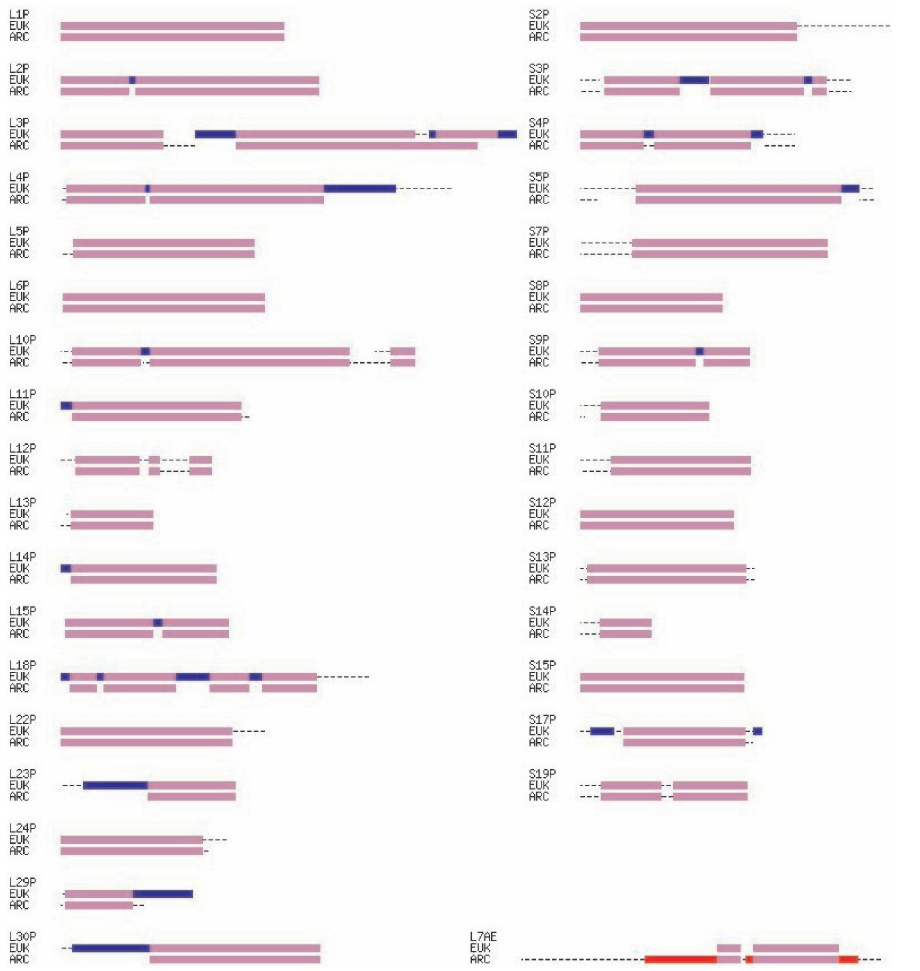
Figure 2. A schematic repre- sentation of the multiple align- ments of the archaeal and eukaryotic species for the 34 universal ribosomal proteins. Purple marks segments alignable, and thus homolo- gous, across both the eukaryal and archaeal phylogenetic do- mains; blue marks segments unique and alignable only among Eukarya; red marks segments alignable only among Archaea. Dotted lines represent sequence regions of varying length that are unalignable across the full sets of either Eukarya or Archaea. The representative species are listed in the legend of Figure 4. Ribosomal protein L7ae has been identified in some, but not all, major representative Bacteria, and is therefore nei- ther universal nor eukaryotic- archaeal